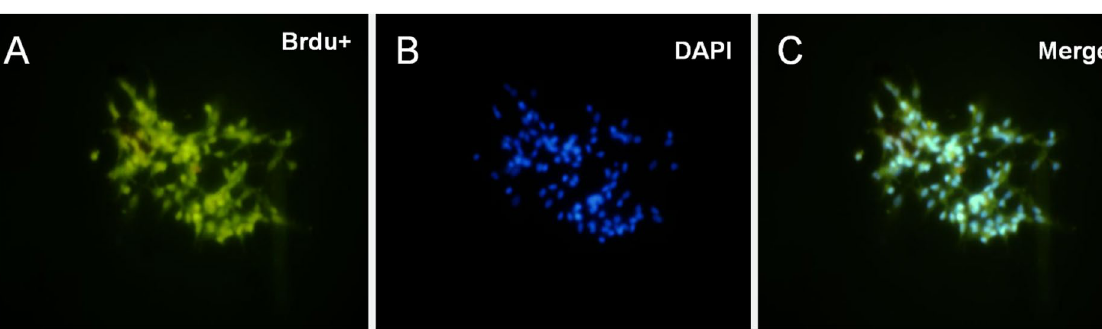
Figure 4. BrdU labeling of EPCs. BrdU-positive cells in culture before transplantation, and majority of the cultured EPCs were